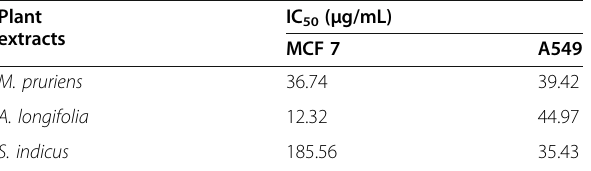
Table 4 IC 50 value of all three plant samples on MCF7 and A549 cell lines